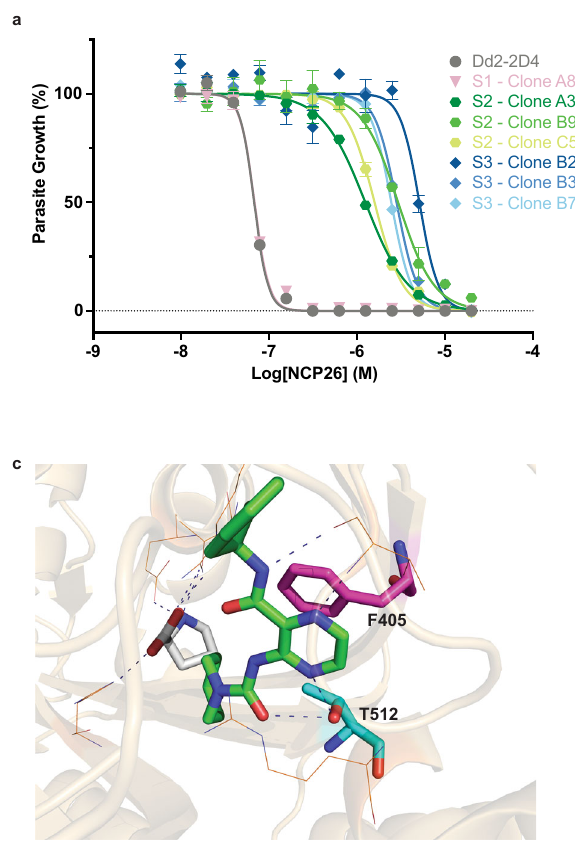
Fig. 3 | NCP26-resistance selection and whole genome sequence analysis. a In vitroactivityofNCP26against ABSP.falciparum Dd2-2D4(parent)orsubclones from three independent resistance selection experiments (S1-3). S1 did not yield resistant parasites and S1 — clone A8 was included for comparison. b In vitro activity of reference compounds against Dd2-2D4 (parent) or subclones from each selection (S1-3). Reference compounds include Pf cProRS inhibitors (halofuginone and halofuginol) and non- Pf cProRS inhibitors dihy- droartemisinin (DHA) and borrelidin ( P. falciparum threonyl-tRNA synthetase inhibitor). c Residues T512S (S2) and F405L (S3) were identi fi ed by